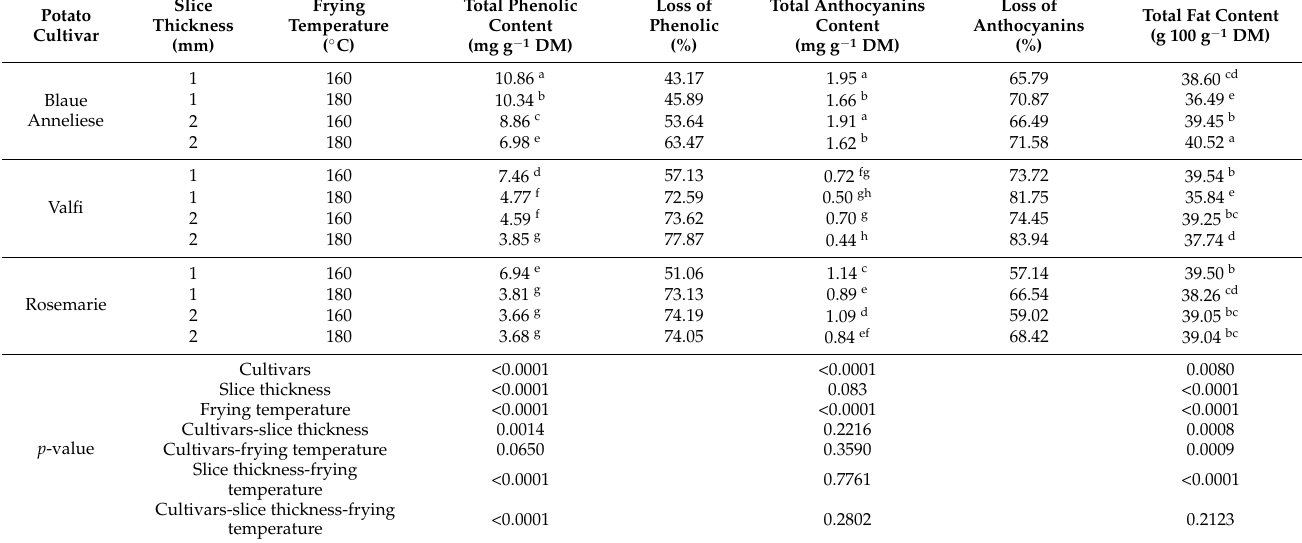
Table 3. The influence of cultivar, slice thickness and frying temperature on the total phenolic content, total anthocyanin content and total fat content of the chips produced from coloured potato